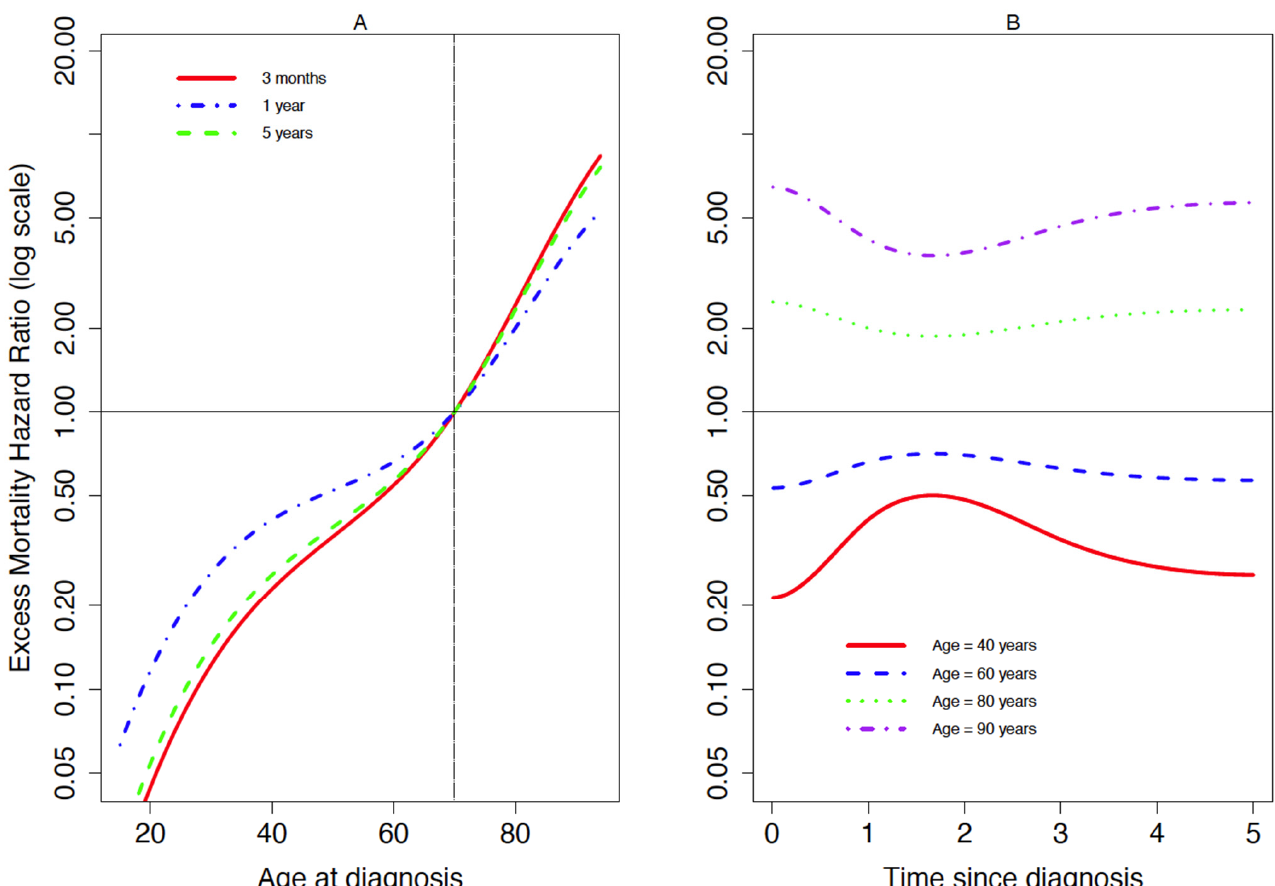
Figure 2. Excess mortality hazard ratios according to ( A ) age at diagnosis at different time since diagnosis (3 months, 1 and 5 years), and ( B ) time since diagnosis for different age groups, amongst patients diagnosed with follicular lymphoma ( n = 15,516) in England during 2005–2013.